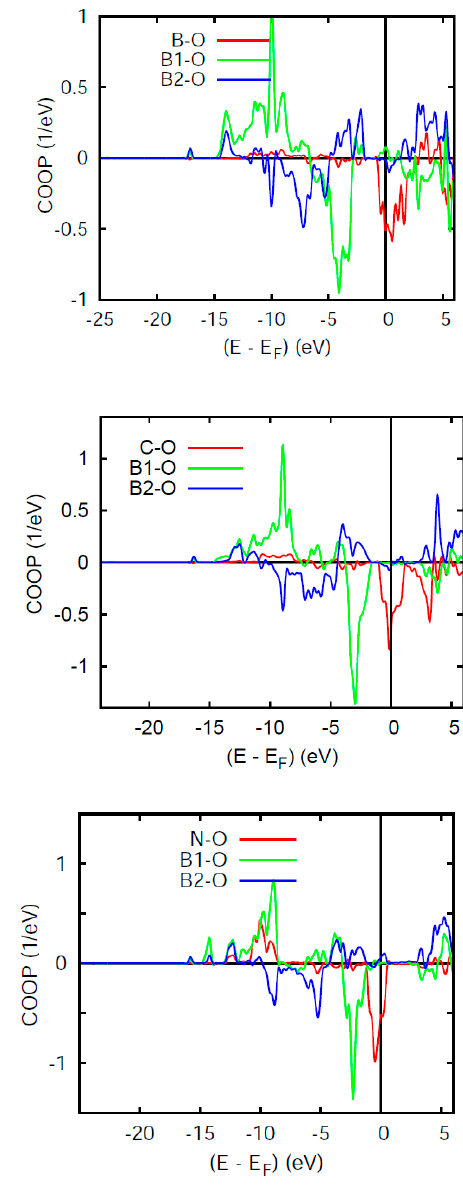
Figure 5. (color). ( a ) Site projected DOS and ( b ) chemical bonding from the COOP criterion of overlap valence popula- tions in B 12 O 2 (top) and B 12 O 2 :O1 (bottom).